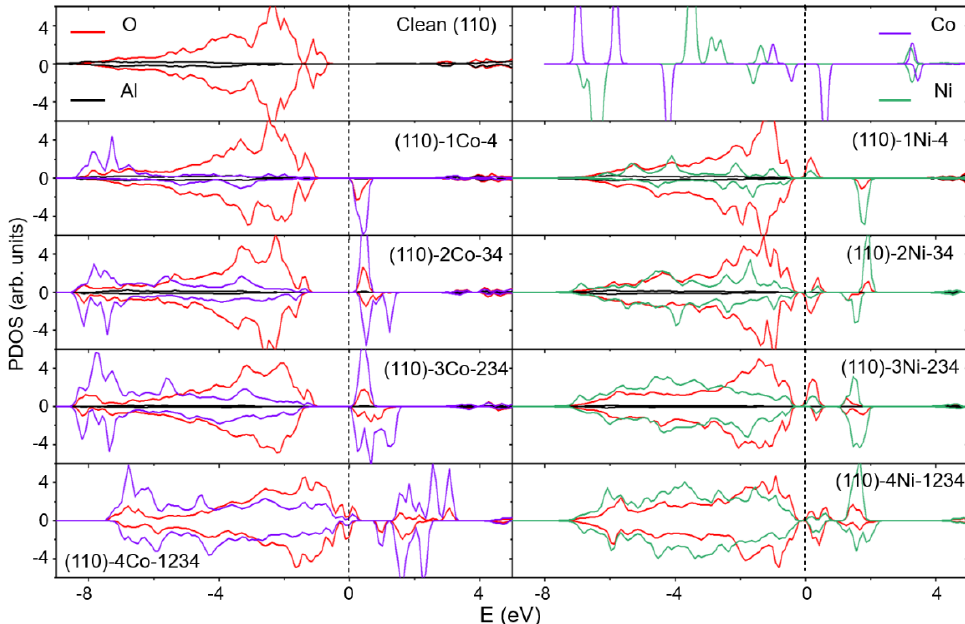
Figure 3. PDOS curves for gas phase Co and Ni atom, perfect and metal substituted γ -Al 2 O 3 (110) surfaces.